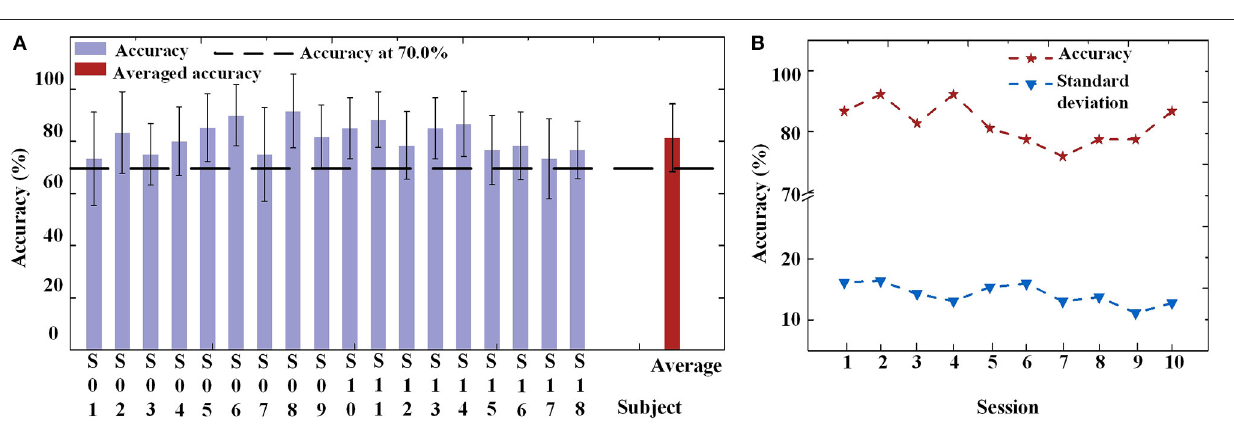
FIGURE 8 | Online performance of prosthesis control. (A) Classification accuracies and standard deviations of each subject and the averaged accuracy. Dotted line is the criterion of 70%. (B) Classification accuracies and standard deviations of each session.